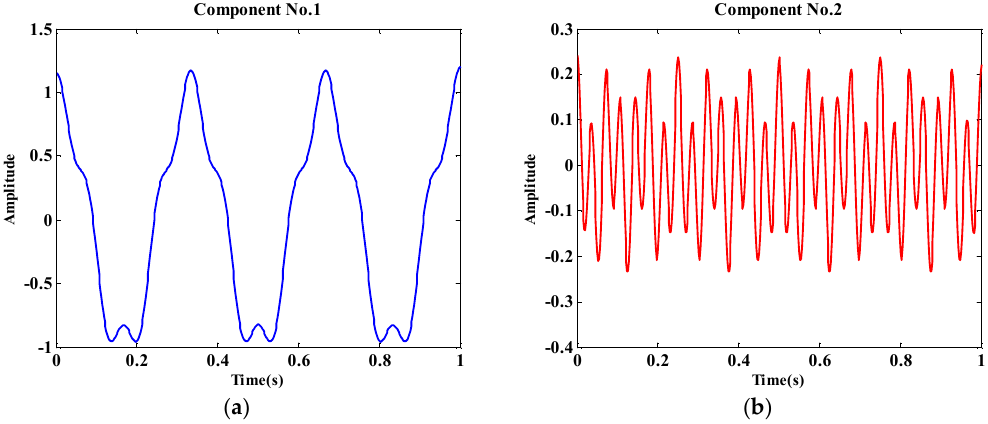
Figure A2. The decomposition result by VMD when K = 3. ( a ) No. 1 mode component; ( b ) No. 2 mode component.